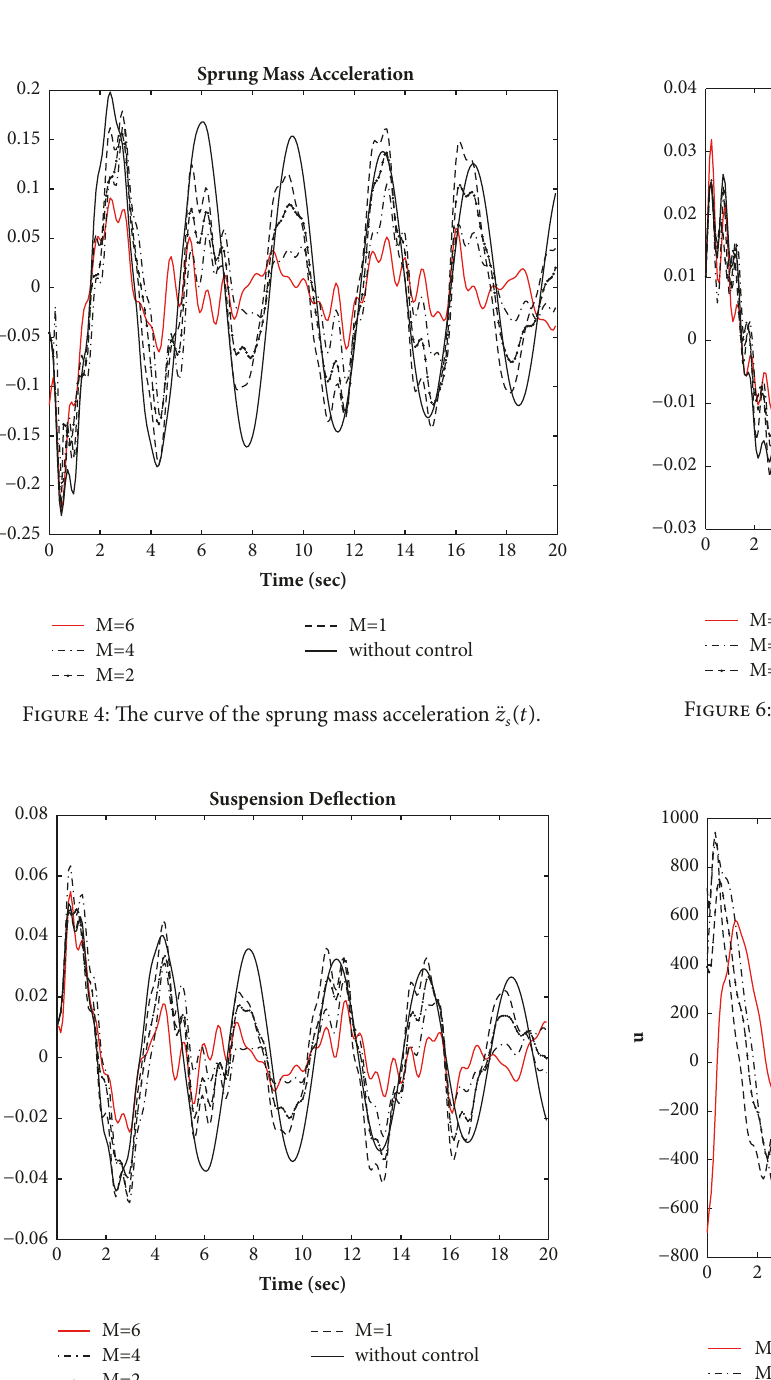
Figure 5: The curve of the suspension deflection 𝑧 𝑠 (𝑡) − 𝑧 𝑢 (𝑡) .